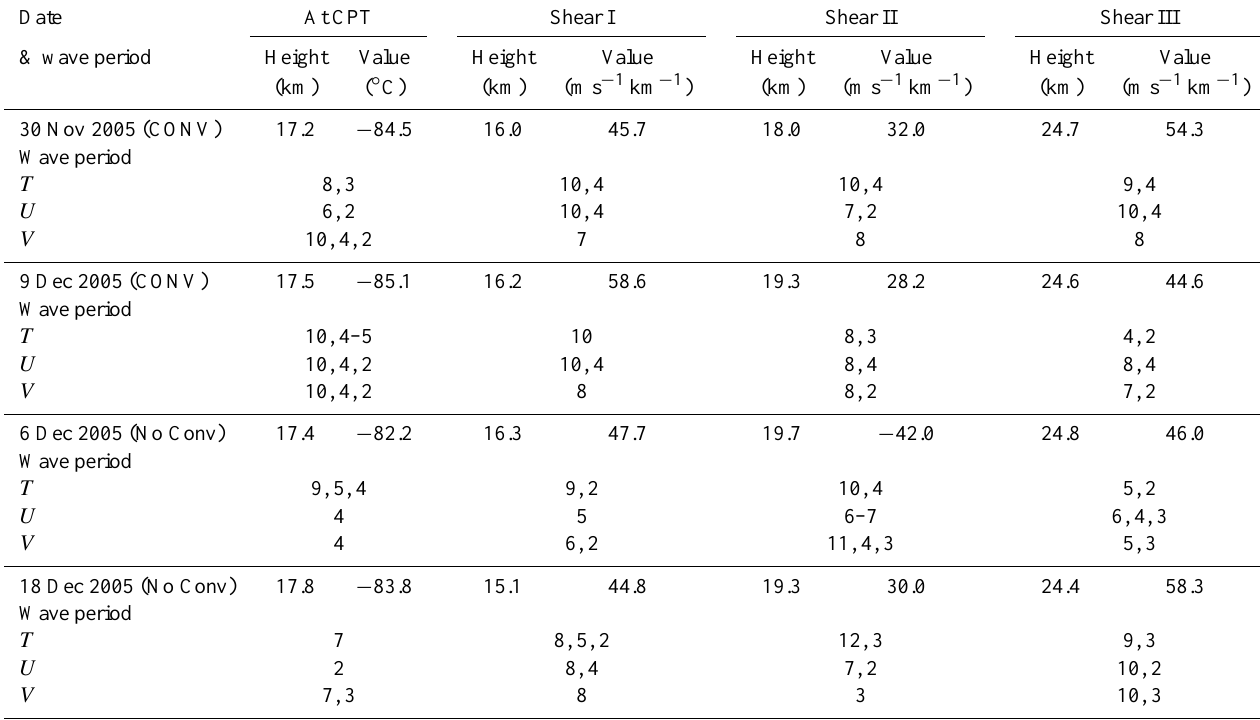
Table 2. Dominant wave periods in temperature ( T ) and wind components (both U and V ) at CPT, WS1, WS2, and at WS3 along with information on wind shear and tropopause. The computed values of wave periods are rounded off to the nearest integer. Different periods in the UTLS region are the manifestation of change in stability and presence of strong wind